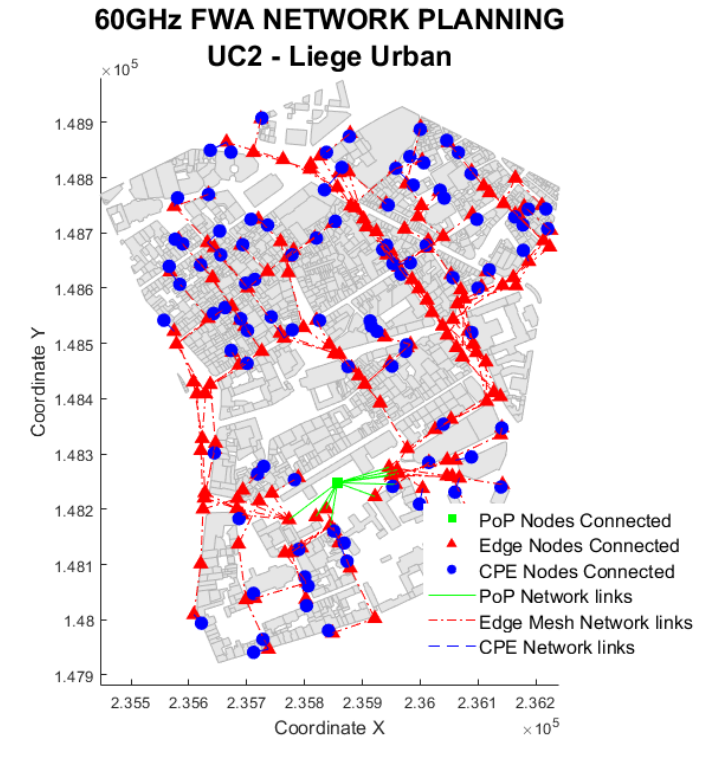
Figure 10. Use Case 2 solution example. Snapshot of the urban Liege area.